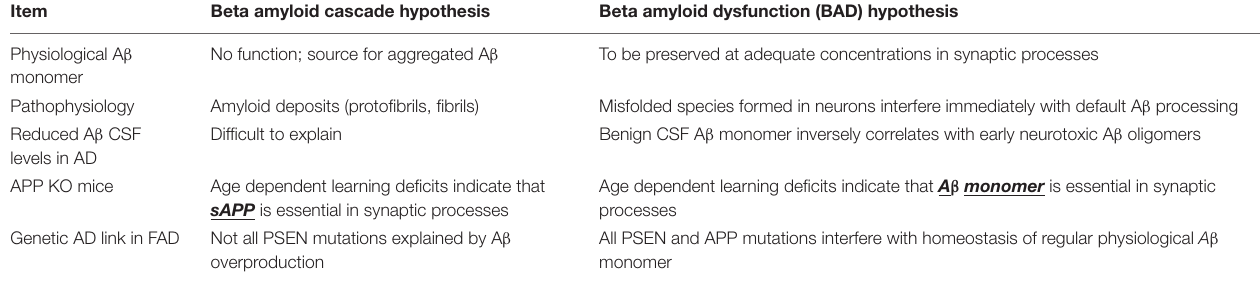
TABLE 2 | BAD vs. cascade hypothesis: key differences. Item